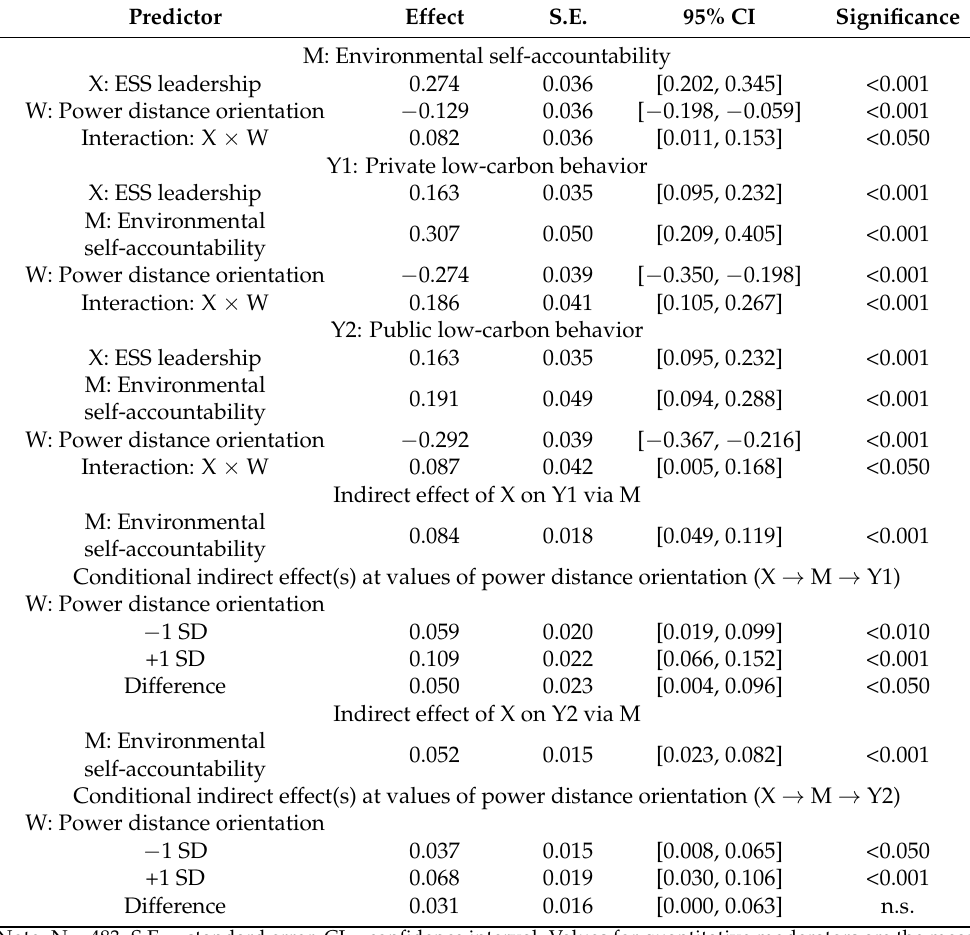
Table 3. Regression results for directing, mediating, and moderating